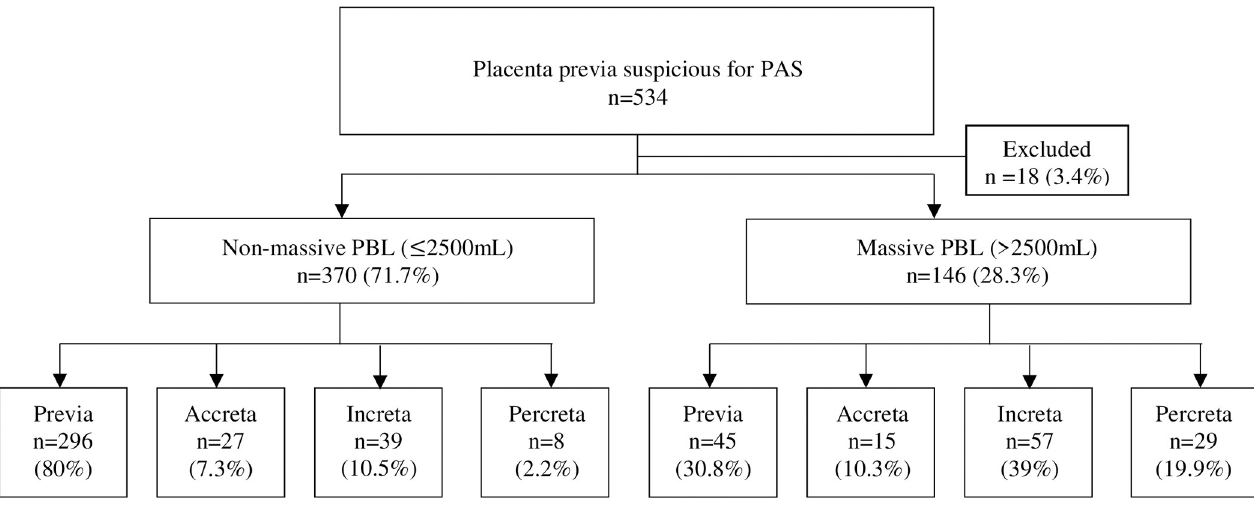
Fig 1. Flow chart of study patients. PAS: placenta accreta spectrum, PBL: perioperative blood loss.